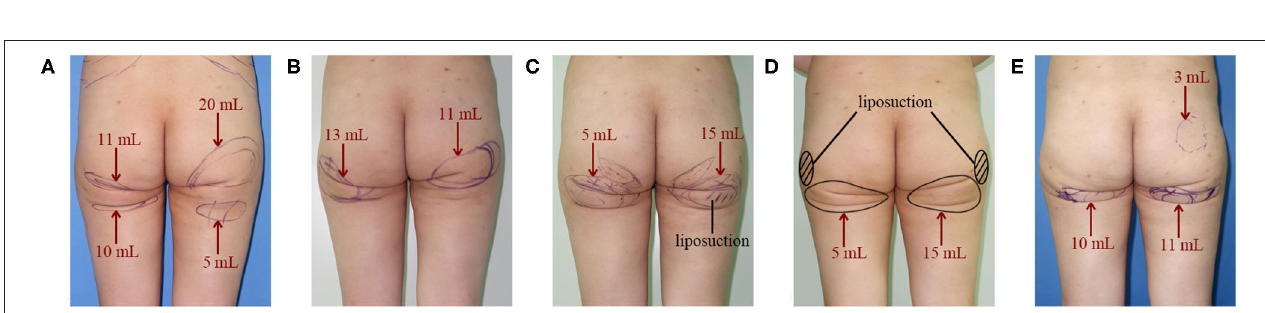
FIGURE 2 | Fat transplantation region and volume of each reconstructive operation. (A) The 1st operation; (B) The 2nd operation; (C) The 3rd operation; (D) The 4th operation; (E) The 5th